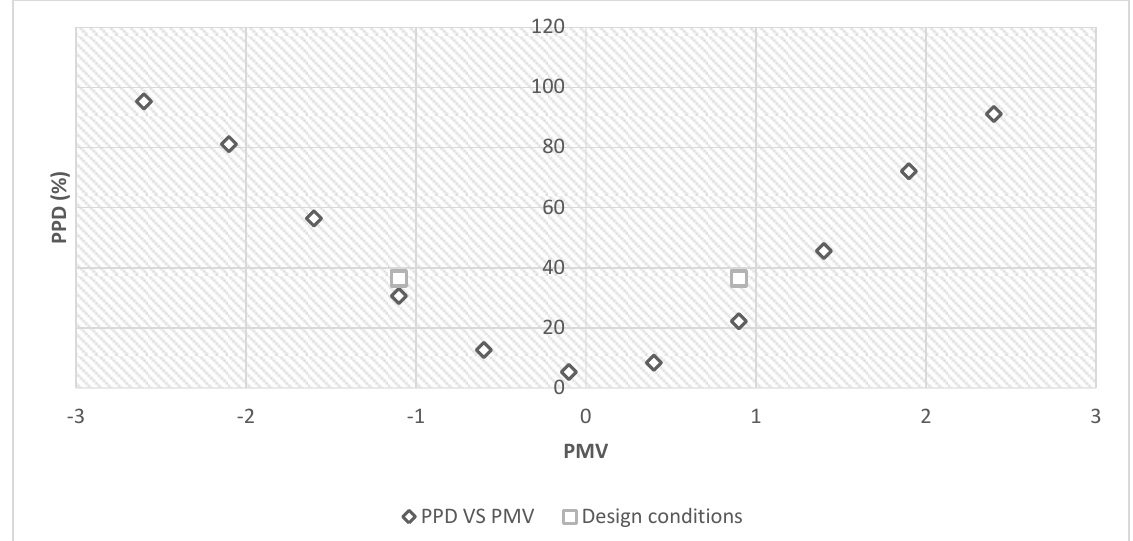
Figure 8 . Graph of the intersection points of the PPD Vs PMV function in relation to the design